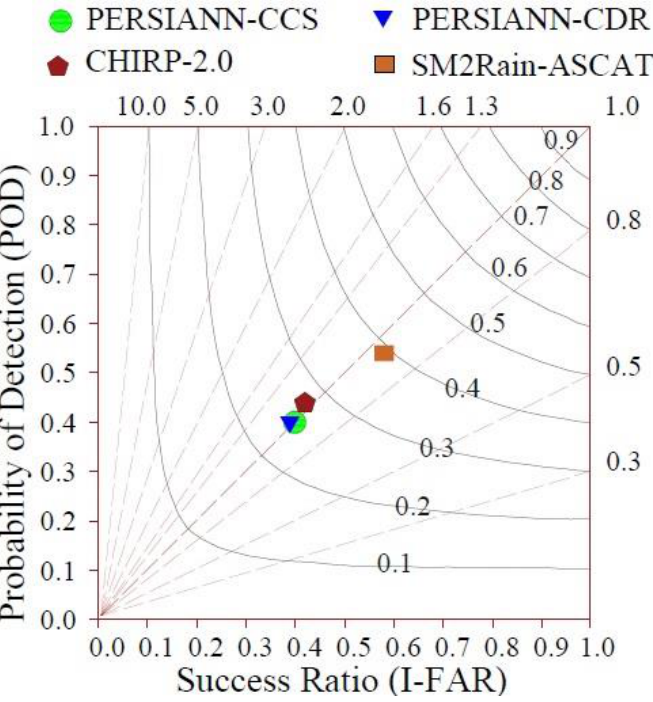
Figure 12. Performance diagram demonstrating the skill of four SRPs (PERSIANN-CDR, PER- SIANN-CCS, CHIRPS-2.0, and SM2Rain-ASCAT) in detecting the daily rainfall over Punjab Prov- ince.